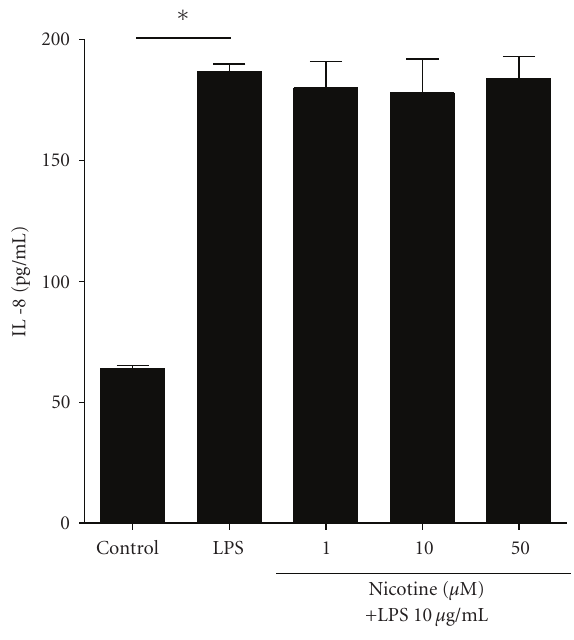
Figure 4: No e ff ect of nicotine on LPS-induced IL-8 protein production in CFTE29o- cells. CFTE29o- cells (1 × 10 5 /mL) were left untreated or stimulated with increasing doses of nicotine (0– 50 μ M) for 1 hour. Following this, samples were either left untreated or treated with Pseudomonas LPS (10 μ g/mL, 24 hours). Levels of IL- 8 in supernatants were measured by ELISA and values are expressed in pg/mL ( ∗ P ≤ . 05). Assay was performed in triplicate ( n = 4).